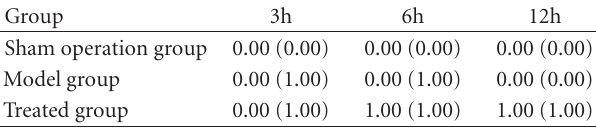
Figure 8: Model group: 12 hours; Caspase-3 ×